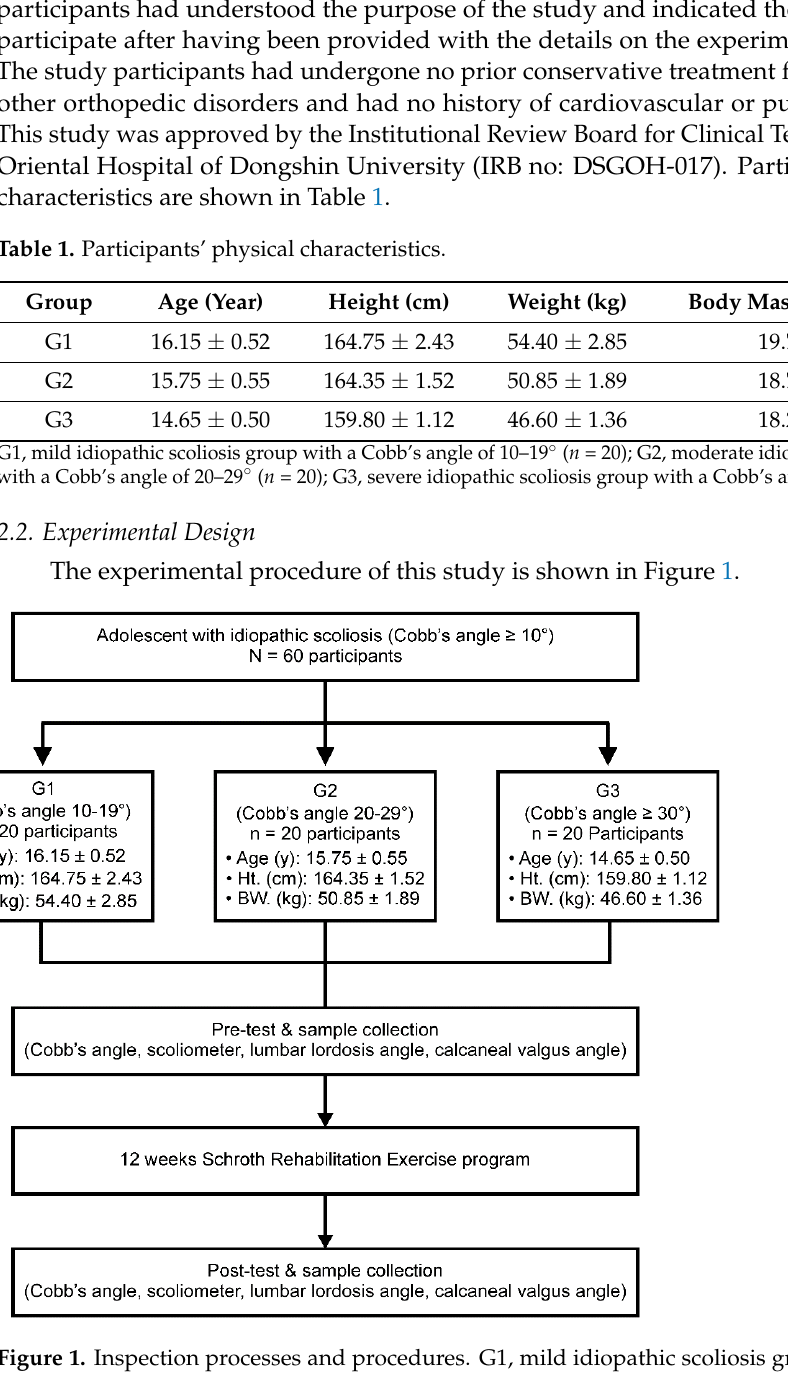
Figure 1. Inspection processes and procedures. G1, mild idiopathic scoliosis group with a Cobb’s angle of 10–19° ( n = 20); G2, moderate idiopathic scoliosis group with a Cobb’s angle of 20–29° ( n = 20); G3, severe idiopathic scoliosis group with a Cobb’s angle of ≥ 30° ( n = 20); Ht., height; BW., ( n = 20); G3, severe idiopathic scoliosis group with a Cobb’s angle of ≥ 30 ◦ ( n = 20); Ht., height; bodyweight. BW.,